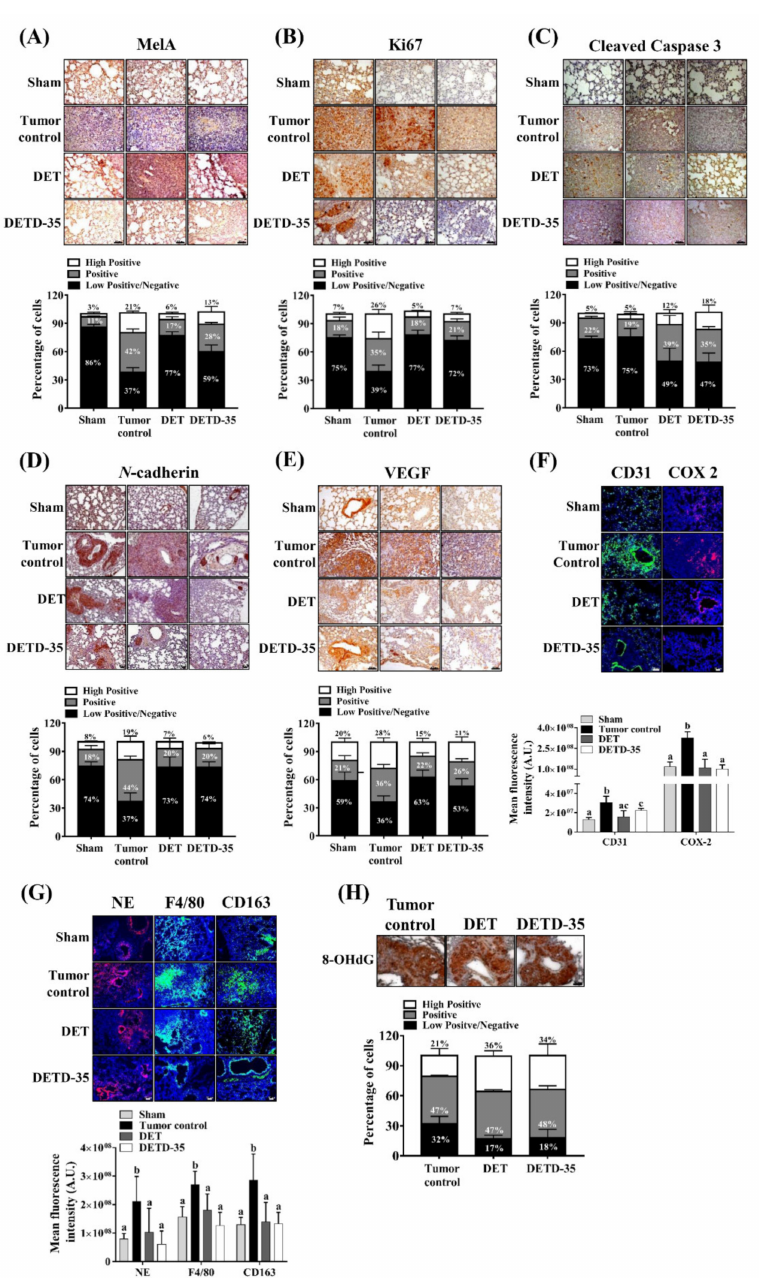
Figure 7. Effect of DET and DETD-35 on various protein markers in the lungs of metastatic melanoma mice. A – E : The representative images of ( A ) Mel-A, ( B ) Ki67, ( C ) cleaved caspase-3, ( D ) N -cadherin, and ( E ) VEGF expression in lung tissues from sham, tumor control, DET- (20 mg/kg) and DETD-35- (20 mg/kg) treated mice. The quantification data were analyzed by IHC profiler plugin, ImageJ. The percentage of positive-staining intensity for each specific protein categorized as high positive, positive, and low positive/negative are summarized. Data are mean ± SD, n = 4. F – G : The represen- tative immunofluorescence images of ( F ) CD31 (green) and COX-2 (red), ( G ) Neutrophils (NE, red), macrophages (F4/80, green) and M2-like macrophages (CD163, green) in lung tissues from sham, tumor control, DET- (20 mg/kg) and DETD-35- (20 mg/kg) treated mice. The quantification was performed using ImageJ software. Data are mean ± SD, n = 4. Means with significant differences